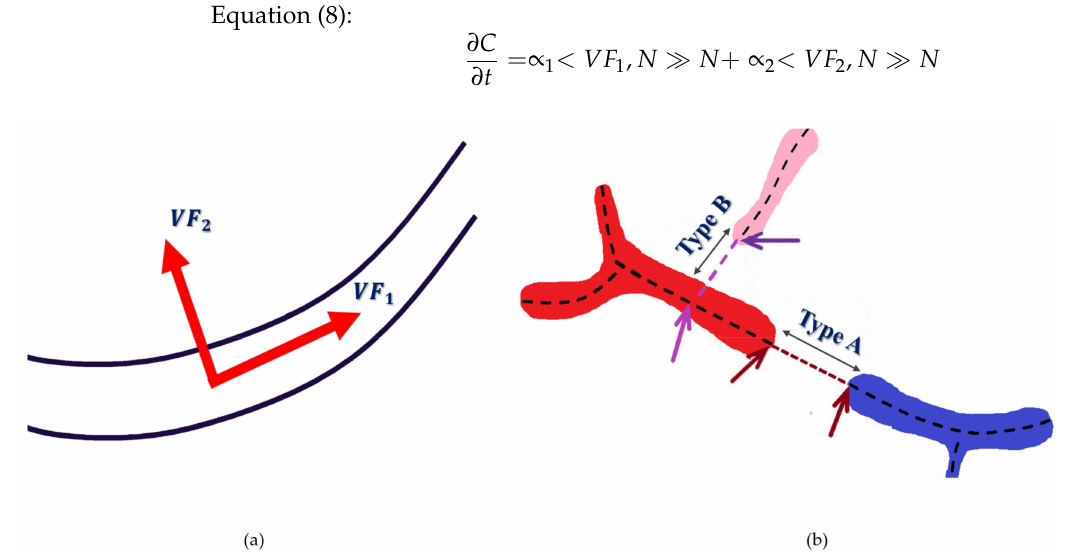
Figure 5. ( a ) Representation of tubularity-flow vector field; ( b ) representation of 2 types of disconti- nuities, Type A and Type B.